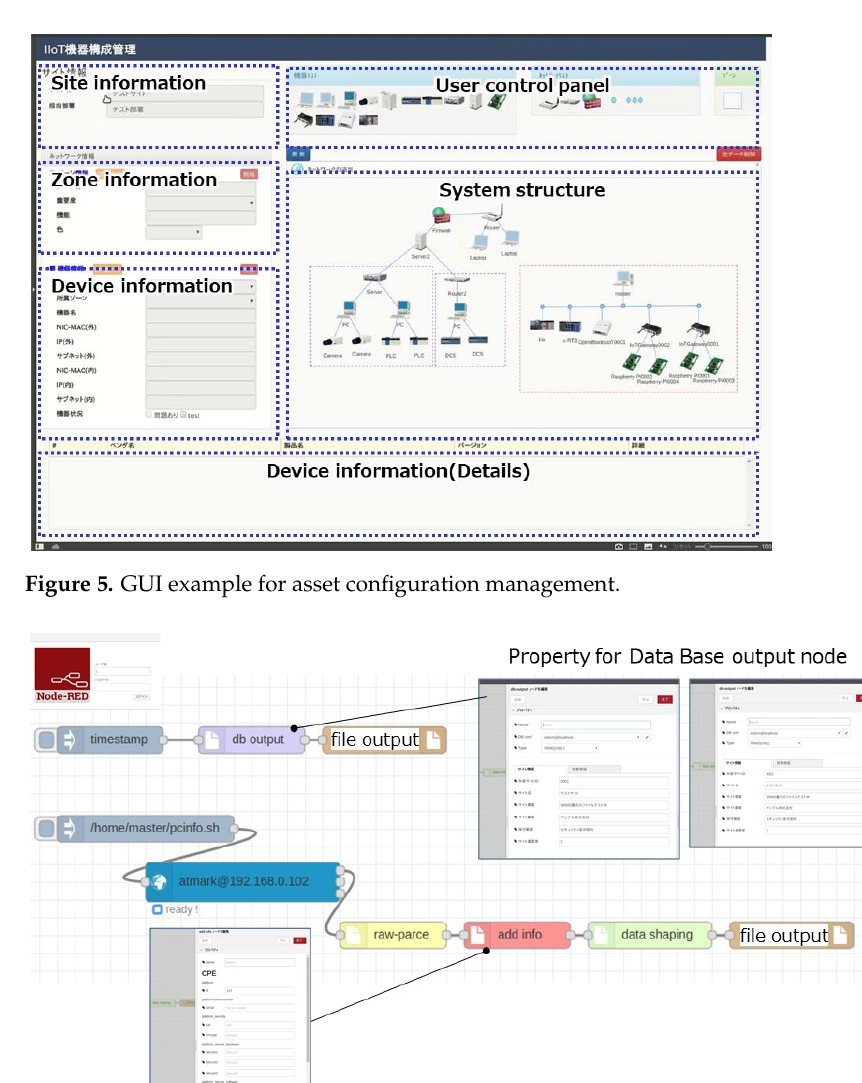
Figure 6. Algorithm design on Node-RED